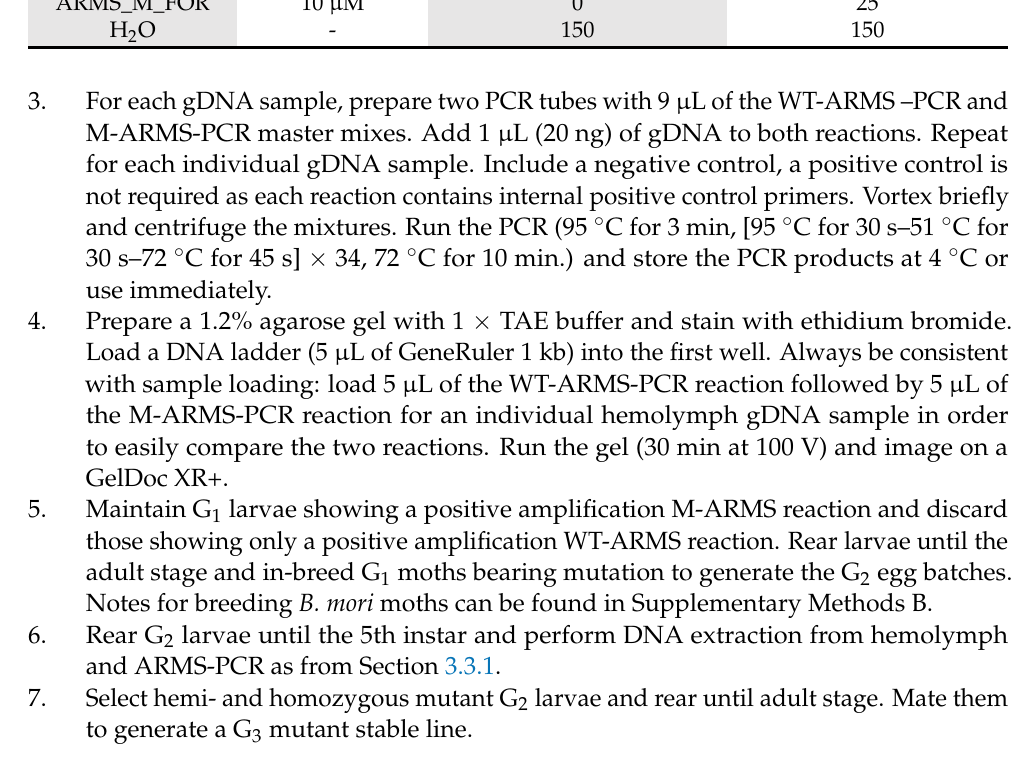
Table 4. Setup of two PCR master mixes for ARMS-PCR screening.